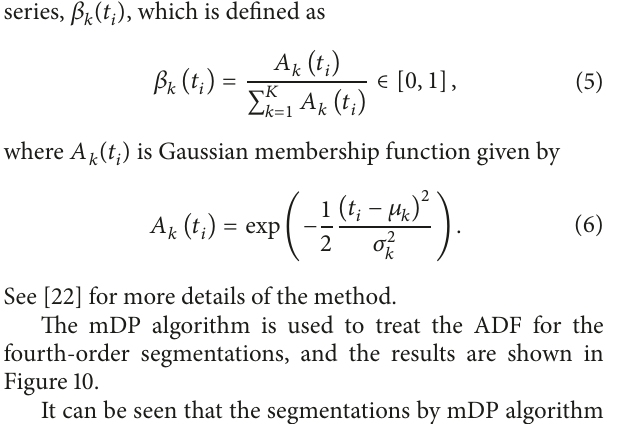
Figure 9. The four clustering results of the ADF are conducted by fuzzy C-means (the data have been